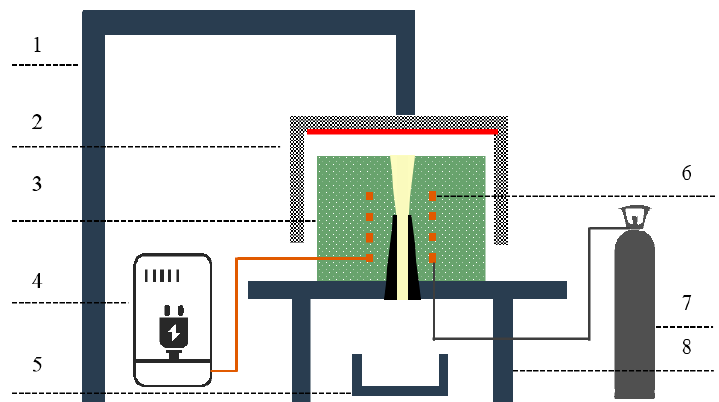
Figure2. SchematicillustrationoftheEICASTexperimentaldevice. 1—Supportstructure; 2—Resistance Figure 2. Schematic illustration of the EICAST experimental device. 1—Support structure;